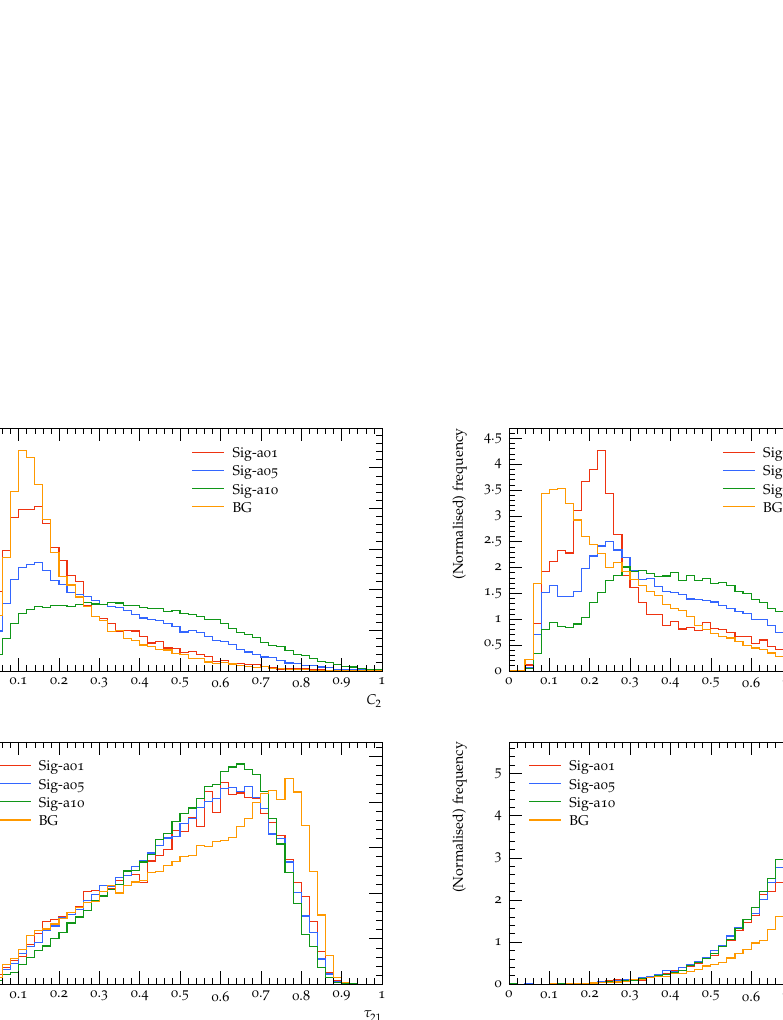
(bottom left) and τ 21 32 values of 0.1, 0.5 HV